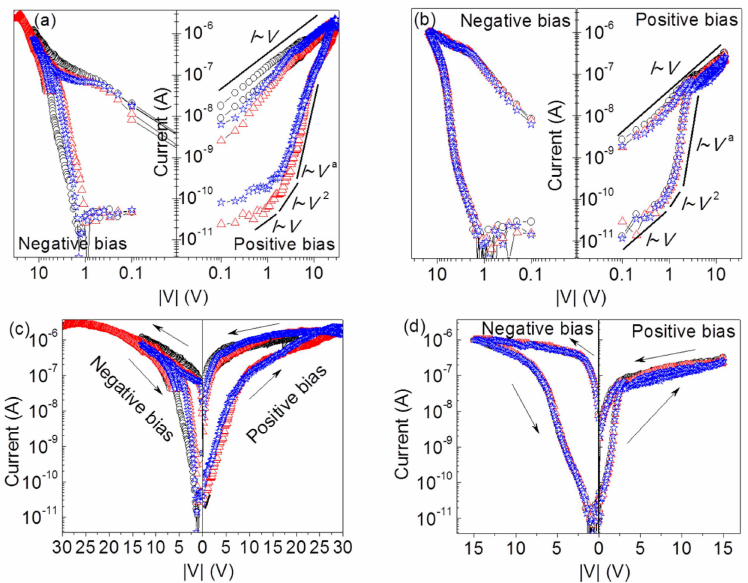
Figure 1. Reproducible voltage-biased current-voltage ( I – V ) curves of the ZnO nanowires (ZnO NW)–based memories ( a , c ) without and ( b , d ) with argon plasma treatment. Blue ( ☆ ), black ( ○ ) and red ( △ ) symbols respectively represent the 8th, 18th and 28th switching cycles.